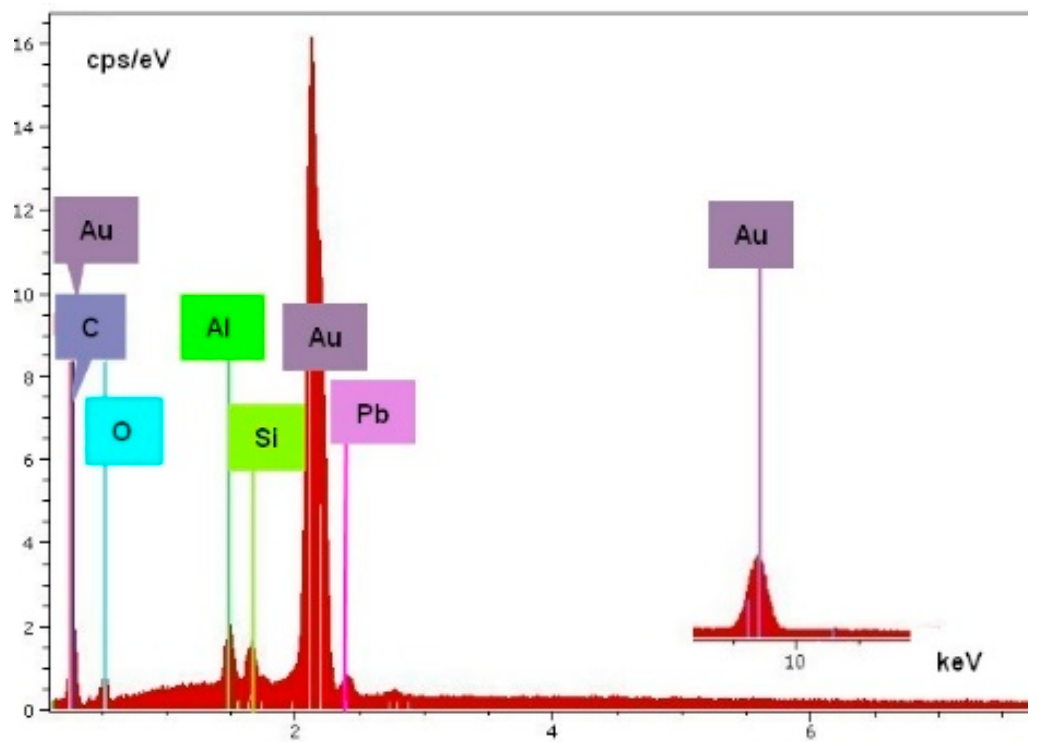
Figure 9. Typical EDS spectrum of the conductive layer.